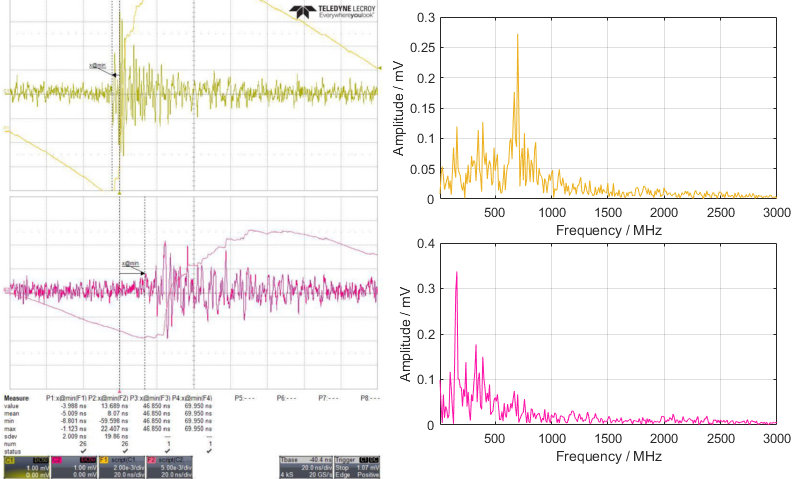
Figure 12. Screenshot of the time ‐ domain signals ( left ) measured with the DSO, and corresponding frequency ‐ domain signal ( right ) created with FFT.